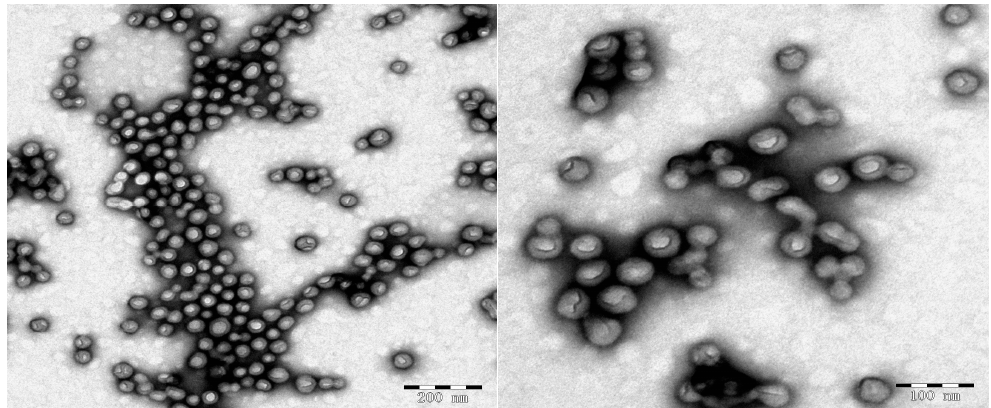
33 - b -NIPAM 163 - b -TFEMA 50 )-S-(C=S)-S-C 12 H 25 nanoparticles. Molecules 2017 , 22 , 152